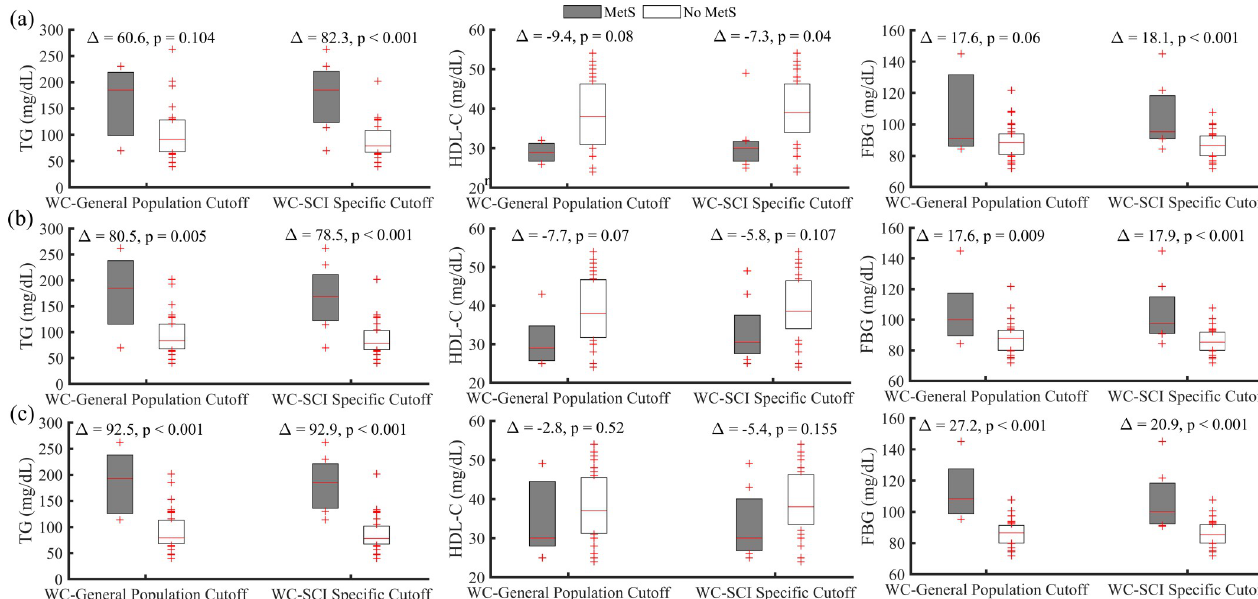
Fig 3. Distribution of triglycerides (TG), high density lipoprotein-cholesterol (HDL-C), and fasting blood glucose (FBG) level between those classified at risk “MetS” and “No MetS” using either general population (102 cm) or SCI specific (86.5 cm) cutoff points of WC. (a): NCEP ATP III, (b): AHA, and (c): IDF. Δ is the mean difference between these variables for participants classified at risk and no risk (“MetS” and “No MetS”). P is the significance value for independent t-test used to determine the differences between groups for TG, HDL-C, and FBG for three definitions of MetS.